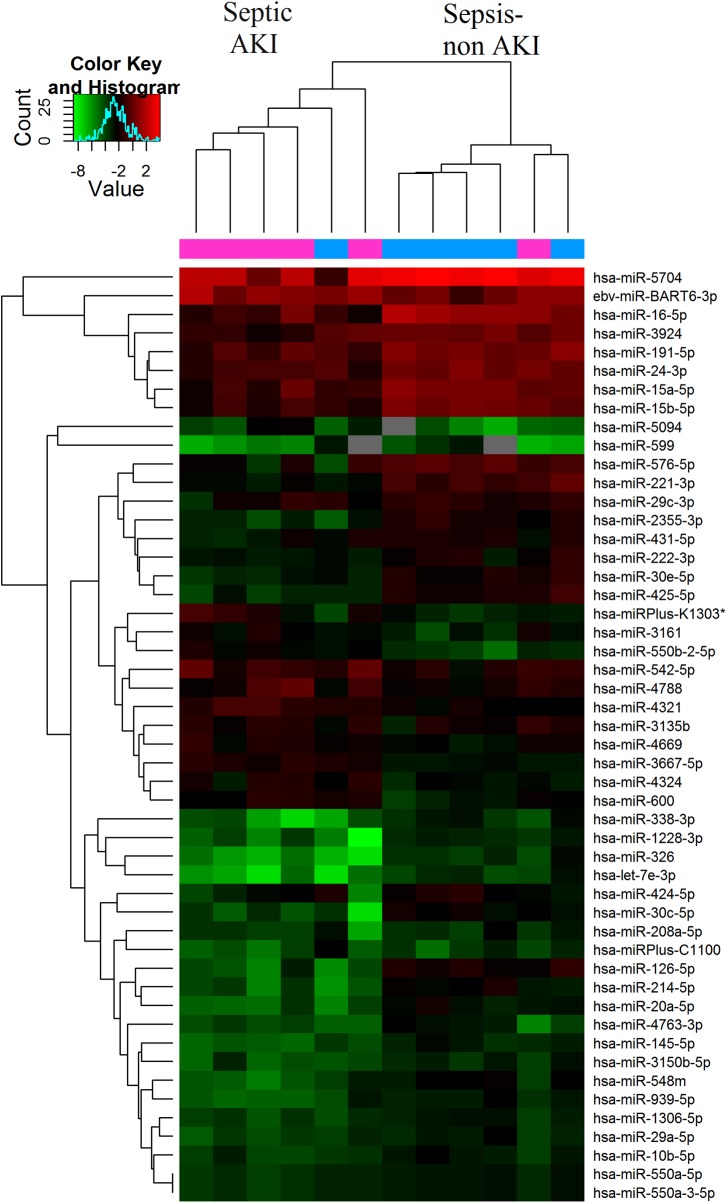
Differentially expressed miRNAs between two groups.Septic AKI (n = 6); Sepsis-non AKI (n = 6). Red color indicated high relative expression and green color denoted low relative expression. miRNA with expression fold change >1.5 and with FDR <0.05 was considered statistically significant.